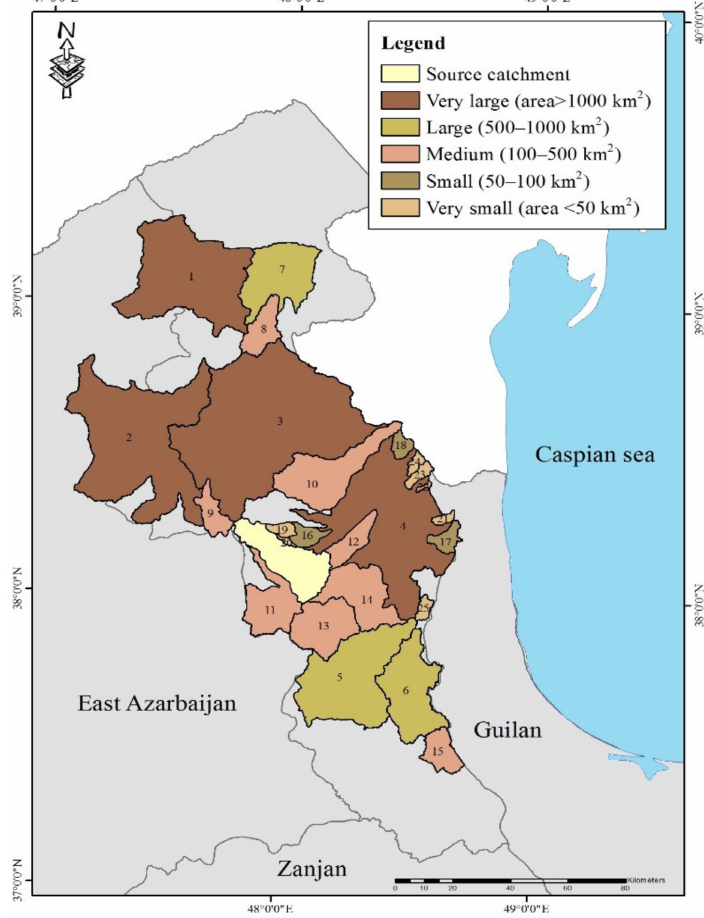
Figure 2. Geographical location of the target